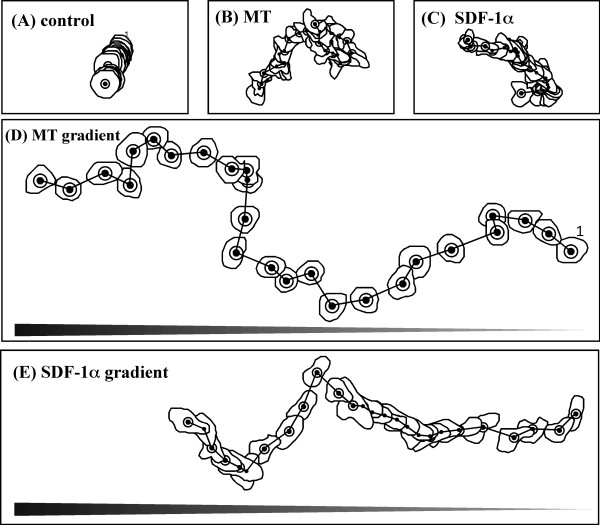
Cell movement in the presence and absence of metallothionein and SDF-1α. Images at 3 minute intervals (over a 75 minute time period) are presented for untreated cells (A), cells treated with a uniform concentration of MT(0.5 μM) (B), or SDF-1α (100 ng/ml) (C), or cells moving under agar in a chemotactic gradient of MT (20 μM) (D) or SDF-1α (200 ng/ml) (E). Each panel has the same number of images and represents the same total time interval. The line at the bottom of panels D and E represents the direction of the chemoattractant gradient from high (wide) to low (narrow). Only cells that have exited the cell well and are clearly visible under the agarose were analyzed.